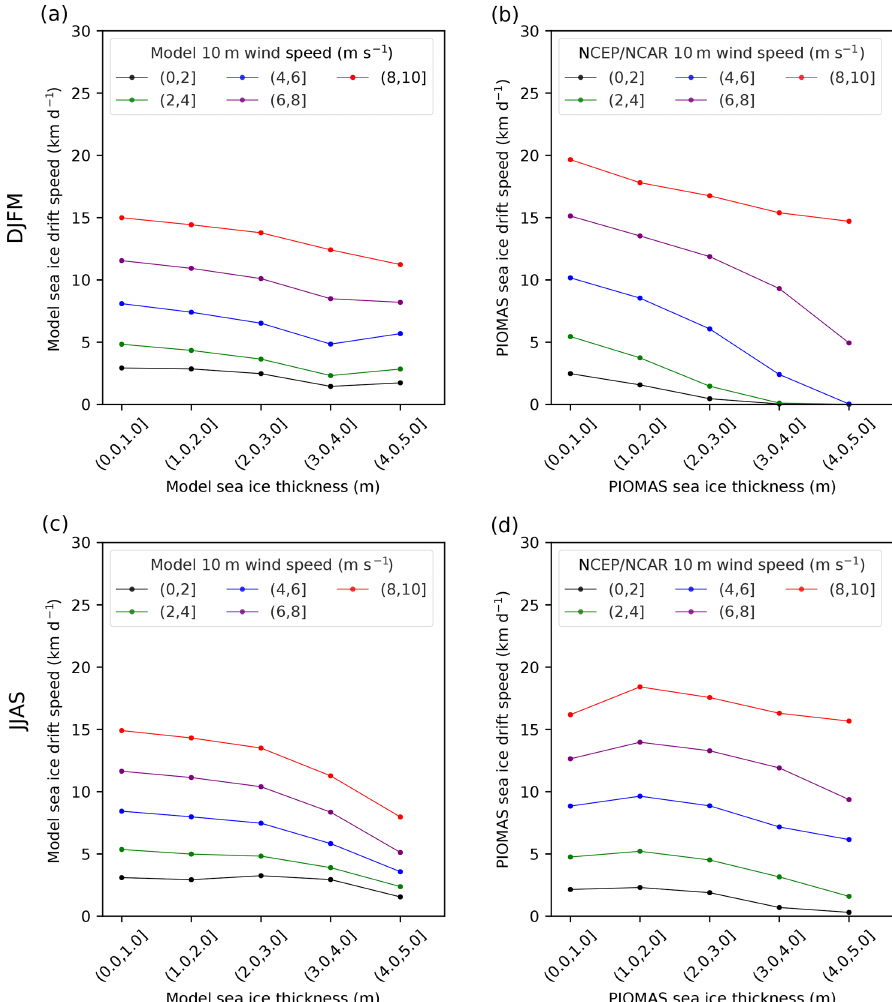
Figure 7. Relationship between sea ice drift speed and sea ice thickness for different near-surface wind speed classes (different colors) for the 2003–2014 (a) winter (DJFM) and (c) summer (JJAS) in the model (HIRHAM–NAOSIM 2.0). Panels (b) and (d) are the same as (a) and (c) , respectively, but based on PIOMAS data. The points in the plot are the median value of all the daily data and on all grid points within the study domain based on Fig. 1. In the labels of different sea ice thickness and 10m wind speed classes, “(” means exclusive and “]” means